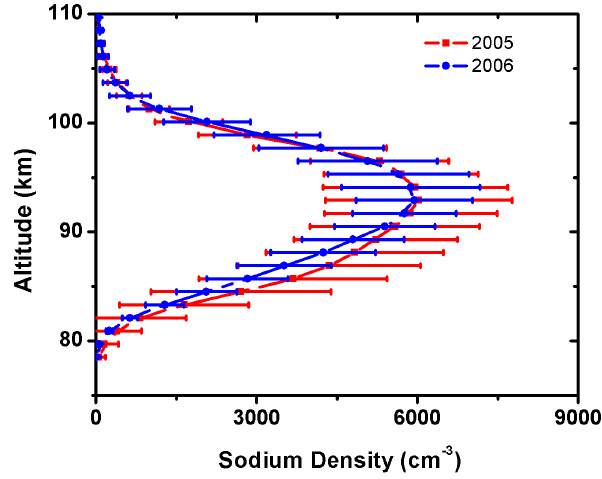
Fig. 10. Annual mean sodium density profiles for the year 2005 and